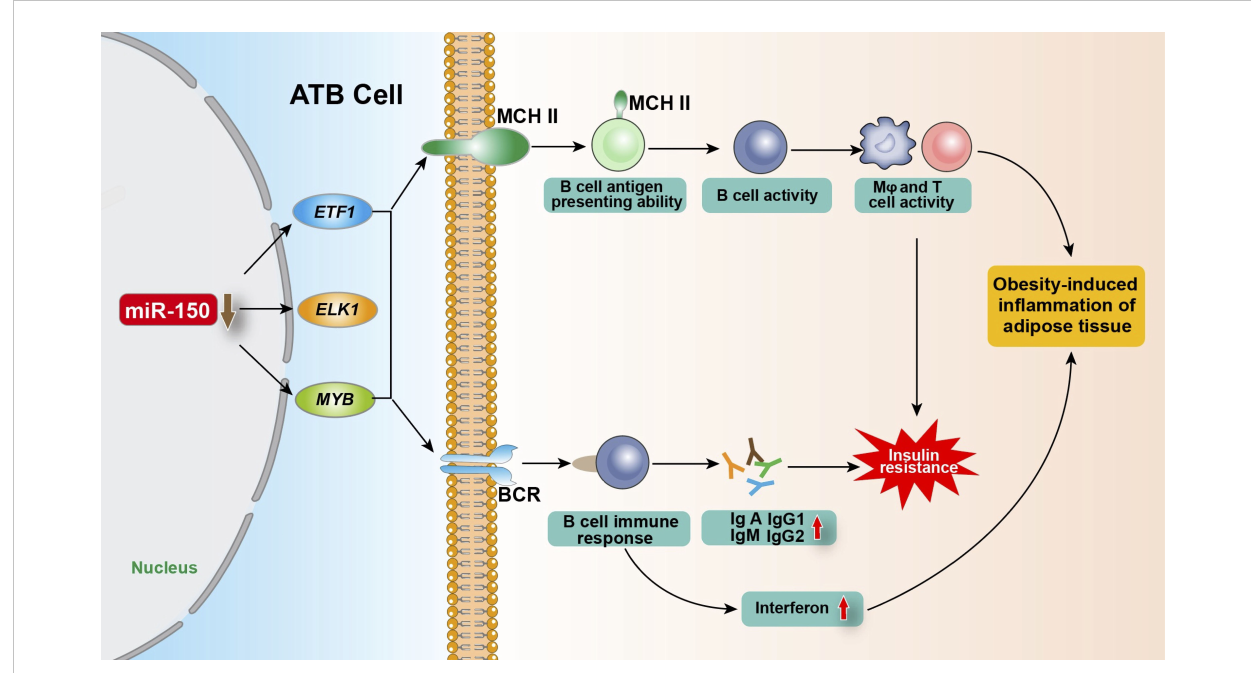
FIGURE 2 Regulation of miR-150 in adipose tissue B cells on obesity-induced adipose tissue in fl ammation and insulin resistance. After being stimulated by antigen, ATB regulate the expression of target genes ETF1 , ELK1 and MYB by reducing miR-150 level, and enhancing the proportion of B cells with MHC II on the cell membrane and the number of MHC II expressed on the B cell membrane so as to improve its antigen presentation ability and its activity as well as enhancing the BCR signaling pathway and immune response, promoting the production of various types of immunoglobulins and interferon, thereby regulating obesity-induced fat tissue in fl ammation and insulin resistance. ATB, adipose tissue B cells; ELK1 , ETS transcription factor; ETF1 , eukaryotic translation termination factor 1; MYB , MYB proto-oncogene; MHC II, major histocompatibility complex II; M j , Macrophages; BCR, B-cell